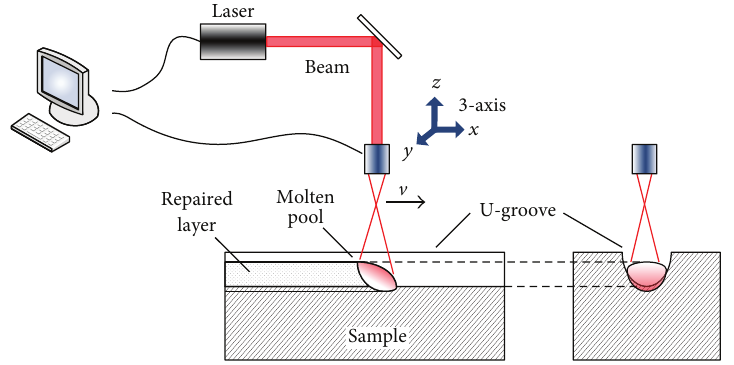
Figure 1: Diagram of a laser repairing system.